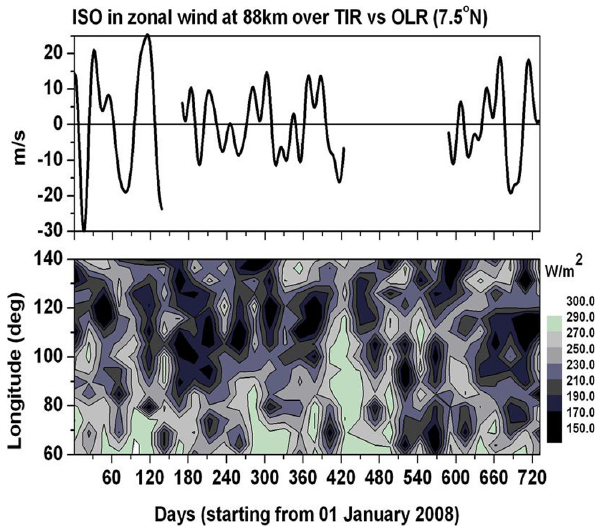
Fig. 8. Bottom panel shows OLR at 7.5 ◦ N latitude (over 60 ◦ E– 140 ◦ E longitude) and top panel shows ISO in zonal wind at 88km over Tirunelveli